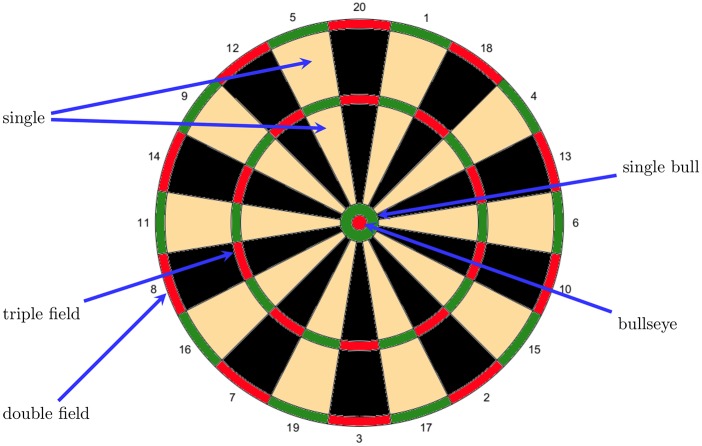
Dartboard layout.